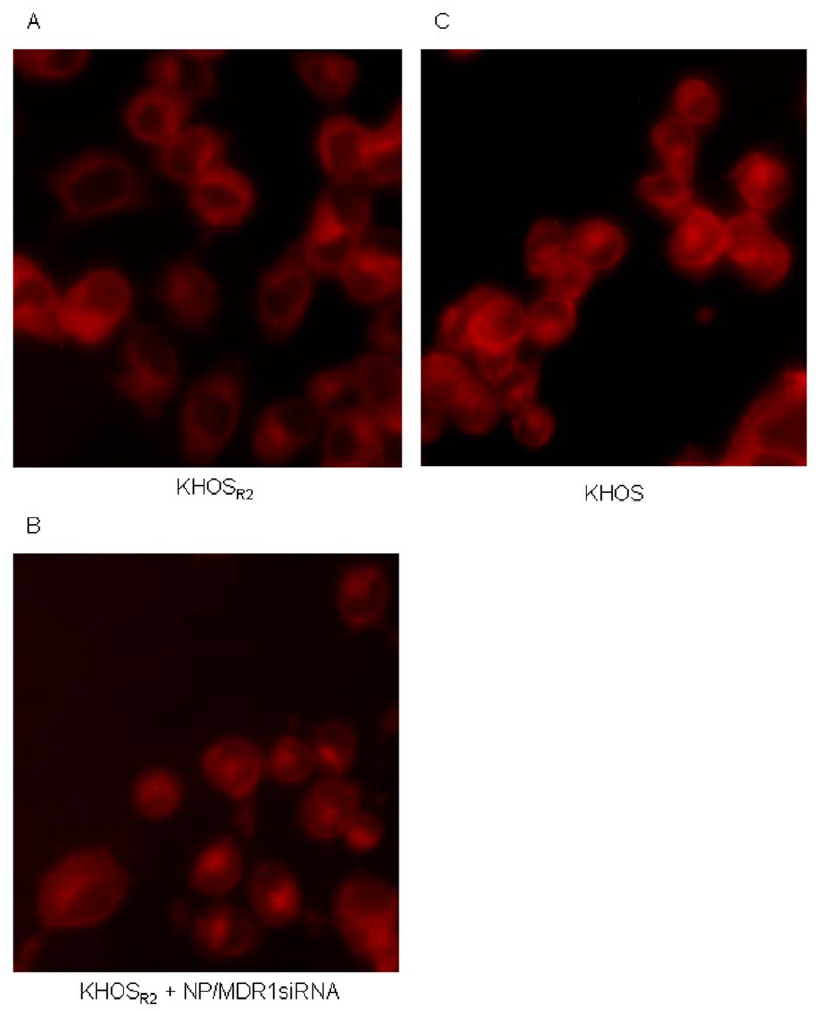
Figure 6. Subcellular distribution of doxorubicin in drug sensitive and resistant osteosarcoma cell lines was analyzed under fluorescence microscope ( A-C ). A prominent increase in fluorescence was observed in the nucleus when multidrug resistant cells were treated with doxorubicin after treatment with MDR1 siRNA loaded nanoparticles.